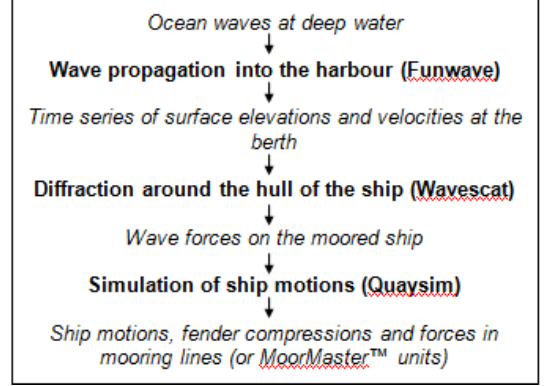
Figure 5. Flow chart of the numerical modelling approach.